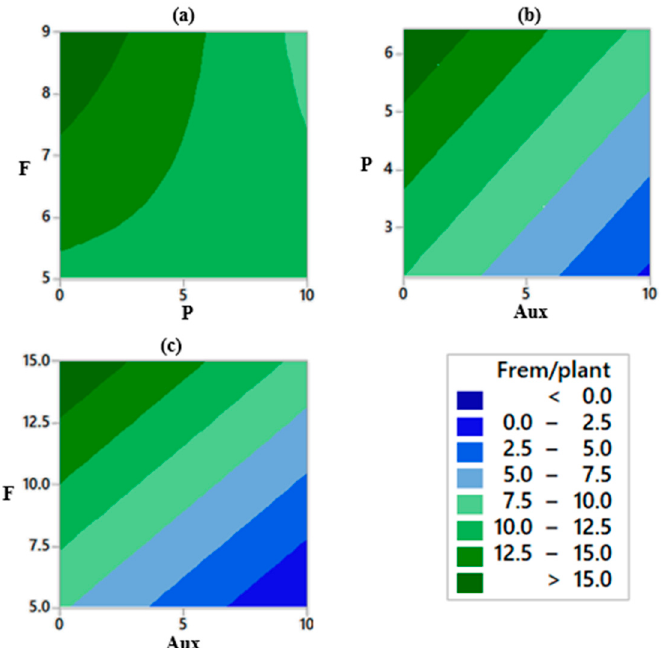
Figure 5. Contour plots for fluoride removal per dry mass of plant. Each plot represent a pair of variables: ( a ) P x F; ( b ) Aux x P; and ( c ) Aux x F. Note: pH and GA 3 were not represented once no significant effect was detected ( α = 10%). For each pair of variables represented in one graph, the other three were held on the values coded as zero (medium), hence Aux = 5 µM, GA 3 = 25 µM, pH = 7, P = 4.28 mg L − 1 , and F = 10 mg L − 1 .